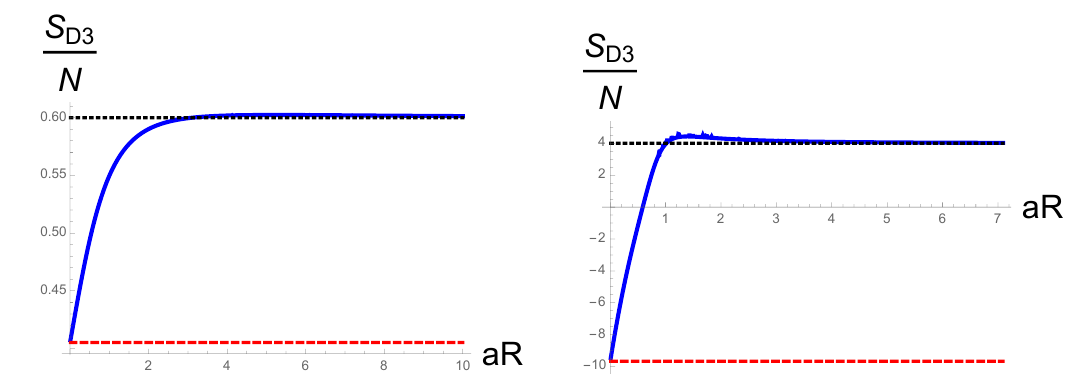
Figure 8 . Left: the D3-brane EE with a > 0 for ~ (cid:20) = 0 : 9 (left) increases with increasing aR . It appears to overshoot slightly the IR value of kS (cid:3) = 2 Right: the overshoot is clearer at larger ~ (cid:20) as shown on right for ~ (cid:20) = 6 : 0 before it settles to the value for k fundamental